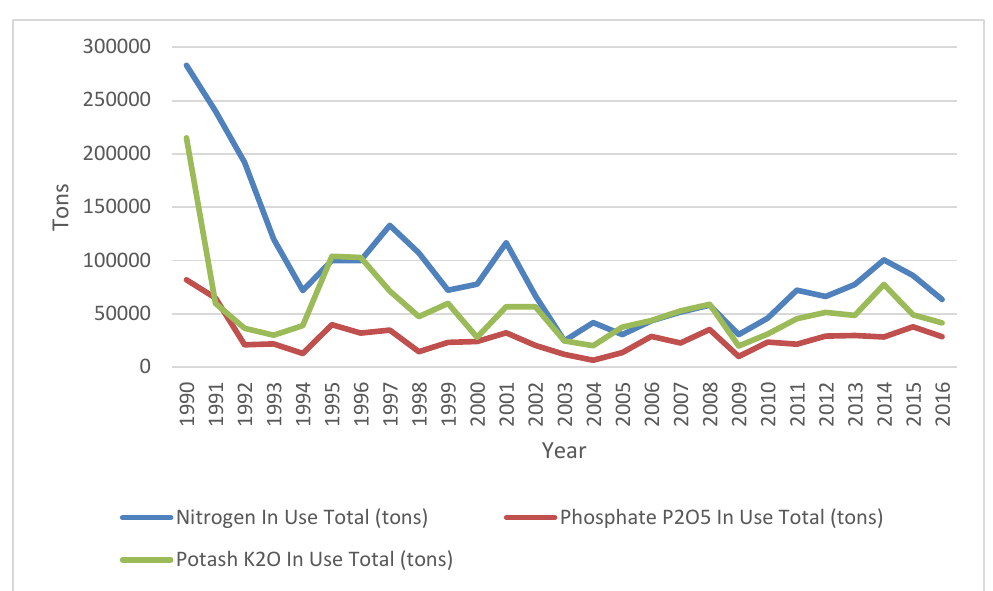
Figure 4. Fertilizer Use,